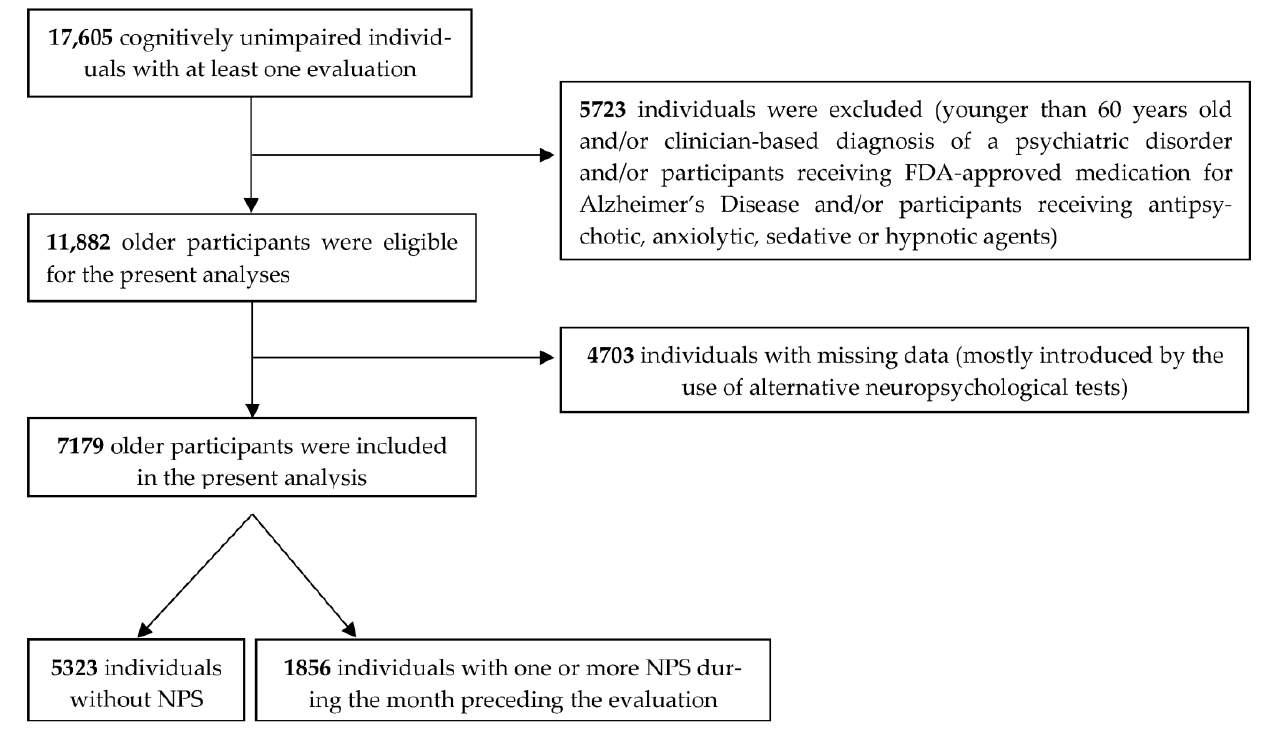
Figure 1. Flowchart of participant selection.